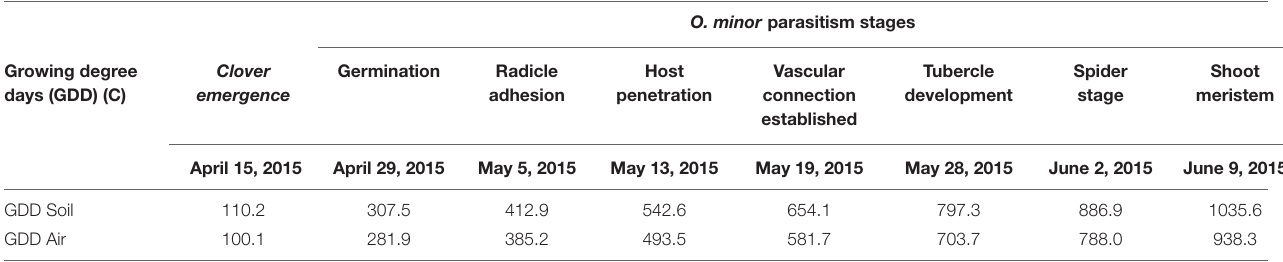
FIGURE 6 | Rescue of methionine inhibition of O. minor radicle growth induced by application of 2.5mM alanine, arginine, aspartate, cysteine, glutamic acid, glutamine, glycine, histidine, homoserine, isoleucine, leucine, lysine, methionine, phenylalanine, proline, serine, threonine, tryptophan, tyrosine, and valine in in vitro assays. ∗ Indicates differences of each treatment compared with the control (radicle growth observed in 2.5 mM methionine treatment) assessed by Dunnett’s test at the 0.05 level. TABLE 1 | Growing degree-days (GDD) accumulated since clover sowing at each O. minor parasitism stage observed based on measurements of soil temperature (5 cm below the soil surface) and air temperature (1 m above soil